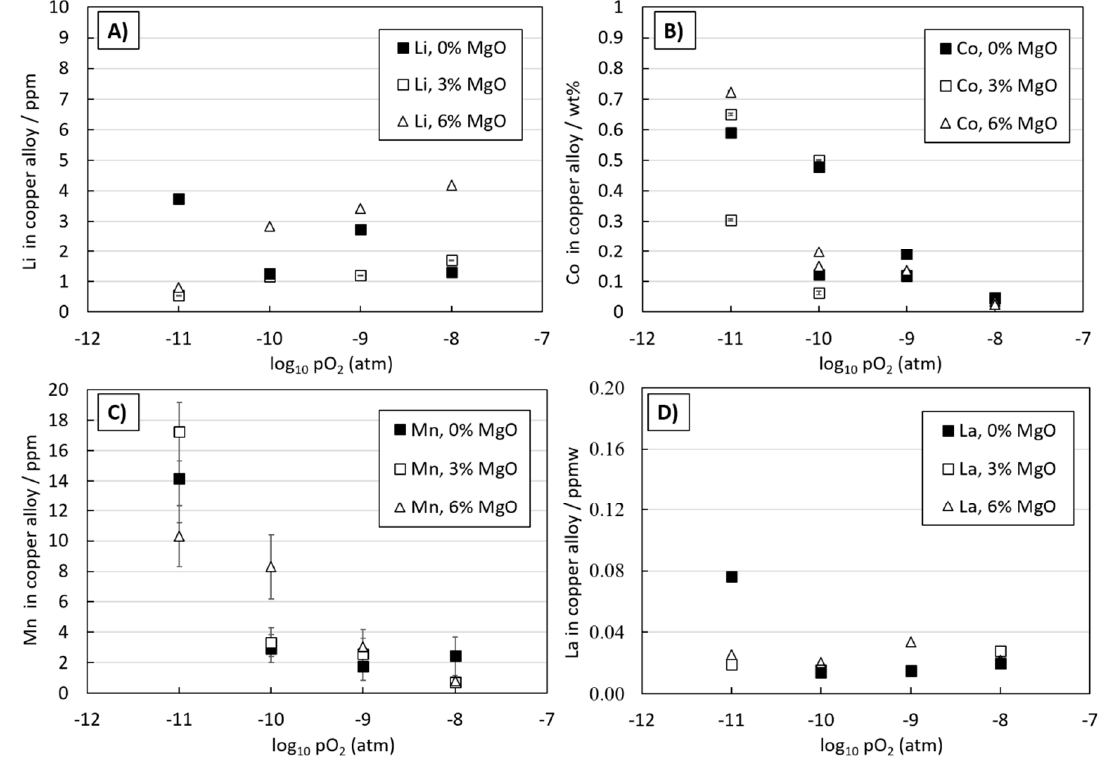
Figure 2. Trace elements ( A ) Li, ( B ) Co, ( C ), Mn, and ( D ) La concentrations in the copper alloy as a function of oxygen partial pressure at 1300 °C.